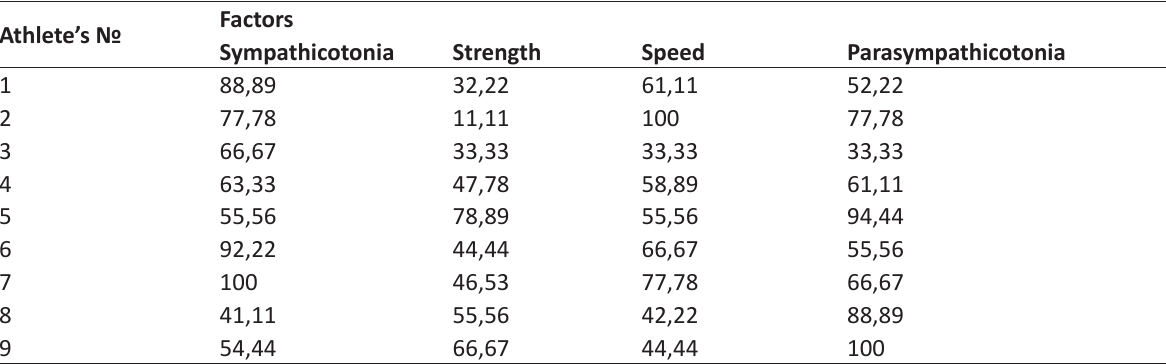
Fig. 1. Factorial structure of athletes’ fitness (n=19) (4 factors are defined): 1 – Factor of “Sympathicotonia”, 28,6%; 2 – Factor “Strength”, 28,5%; 3 – Factor “Speed”, 9,4%; 4 – Factor of “Parasympathicotonia”, 9,2%; 5 – Other factors, 24,3% Table 2. Individual display of factors in structure of athletes (male) fitness’ (% of the maximum display of factor in selection)